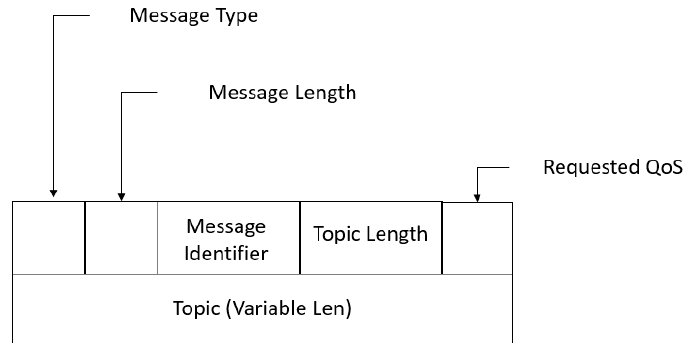
Figure 5. Subscribe request packet structure.